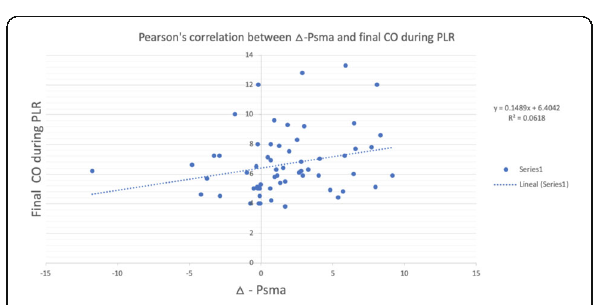
Fig. 2 (abstract 001294). See text for description